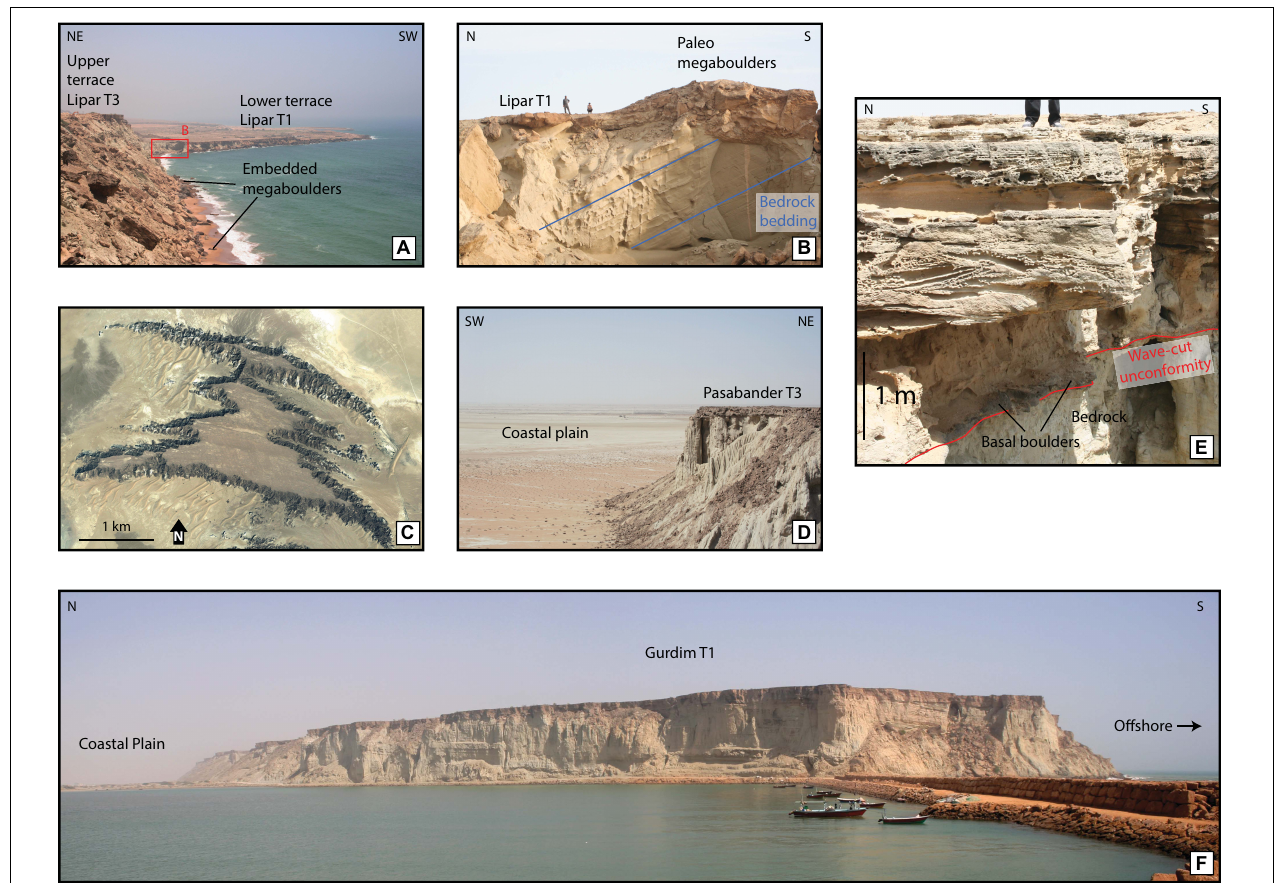
FIGURE 4 | Figures illustrating the Mmt geomorphology and sedimentology. More pictures may be found in Normand et al. (2019a). (A) General view of sandstone-dominated terraces, which have a classic staircase morphology. Here, two terraces of Lipar T1 and T3 are separated by a paleocliff. The Holocene platform is being carved through both T1 and T3 and megaboulders are seen embedded in the small Holocene beach at the feet of T3. T3 is 60 m high. Red square is the position of panel B (25.250 ◦ N, 60.839 ◦ E; looking SE). (B) Close up of the vicinity of the Lipar T1 shoreline angle. Notice the angular unconformity with the bedrock bedding (blue lines) and the fossil version of embedded megaboulders at the foot of the paleocliff (which is situated a few meters to the left of the picture) (25.247 ◦ N, 60.848 ◦ E). (C) Google Earth satellite image of Tang T3, illustrating some morphological properties of marl-type terraces, such as the isolated platform morphology, the finger-like protrusion and the curved aspect, emphasized by lineations on the terrace surface (see also Figure 8G ) (25.42 ◦ N, 59.88 ◦ E). (D) Northern side of Pasabander T3. Note the absence of paleocliff and the highly degraded marl bedrock where unprotected by the terrace deposits (25.134 ◦ N, 61.449 ◦ E). (E) Example of terrace deposit succession (here, section P8 of Figure 6A ) (25.077909 ◦ N, 61.354360 ◦ E). (F) Gurdim terrace seen from its westernmost side. This terrace is one of the best examples of an isolated flat-topped platform. The bedrock is marl, south dipping at a low angle, which emphasizes the angular unconformity with the overlying terrace deposits. The paleocliff, expected in the north of the picture, is